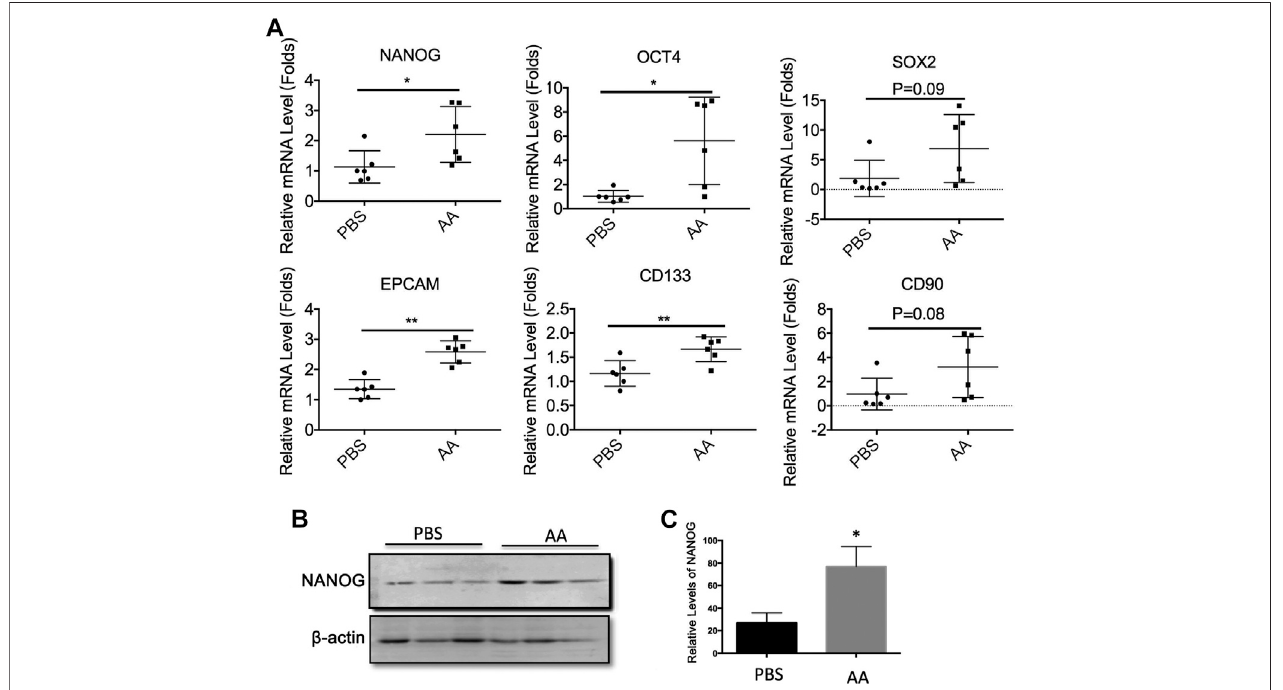
FIGURE 6 | AA regulates the expressions of stemness genes in liver tumors in vivo . 2 × 10 6 Huh7 cells were inoculated subcutaneously into female BALB/c nude mice. Three weeks later, PBS (control group) or 4 g/kg AA were injected introperitoneally twice a day. At the end of treatment, the animals were sacri fi ced and tumors were collected for analysis. ( A) mRNA levels of stemness genes in tumor tissue. (B,C) Protein levels of NANOG in tumor tissue. * p < 0.05. ** p < 0.01.